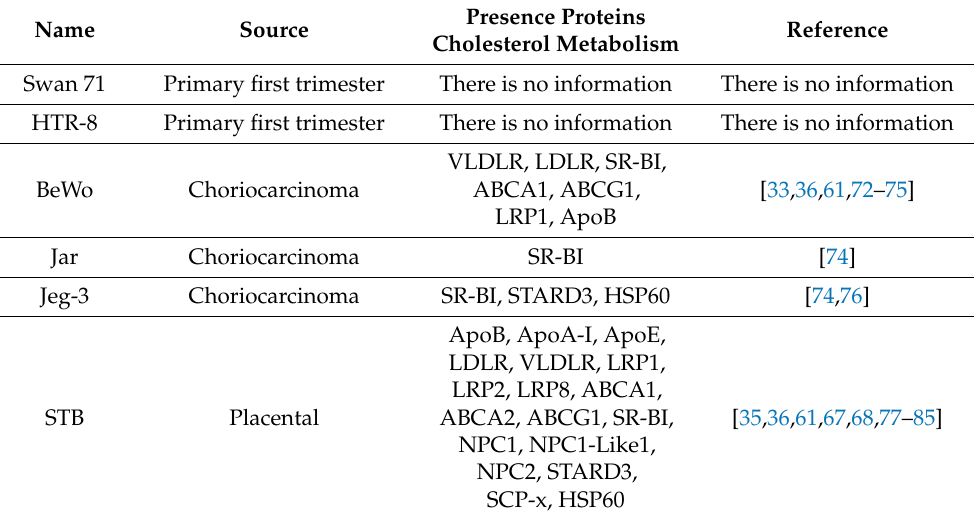
Table legend: A summary of the published information on proteins involved in the transport and metabolism of cholesterol in different placental cell lines. STB: syncytiotrophoblast; VLDLR: Very-low-density-lipoprotein receptor; LDLR: Low-density lipoprotein receptor; SR-BI: Scavenger receptor class B type 1; ABCA1: ATP-binding cassette transporter; ABCG1: ATP-binding cassette Subfamily G Member 1; LRP1: Low-density lipoprotein receptor-related protein 1; ApoB: Apolipoprotein B; STARD3: StAR Related Lipid Transfer Domain Containing 3; HSP60: Heat Shock Protein 60; ApoA-I: Apolipoprotein A1; ApoE: Apolipoprotein E; LRP2: Low-density lipoprotein receptor-related protein 2; LRP8: Low-density lipoprotein receptor-related protein 8; ABCA2: ATP- binding cassette transporter ABCA2; NPC1: Niemann–Pick type C 1; NPC1-Like1: Niemann–Pick type C